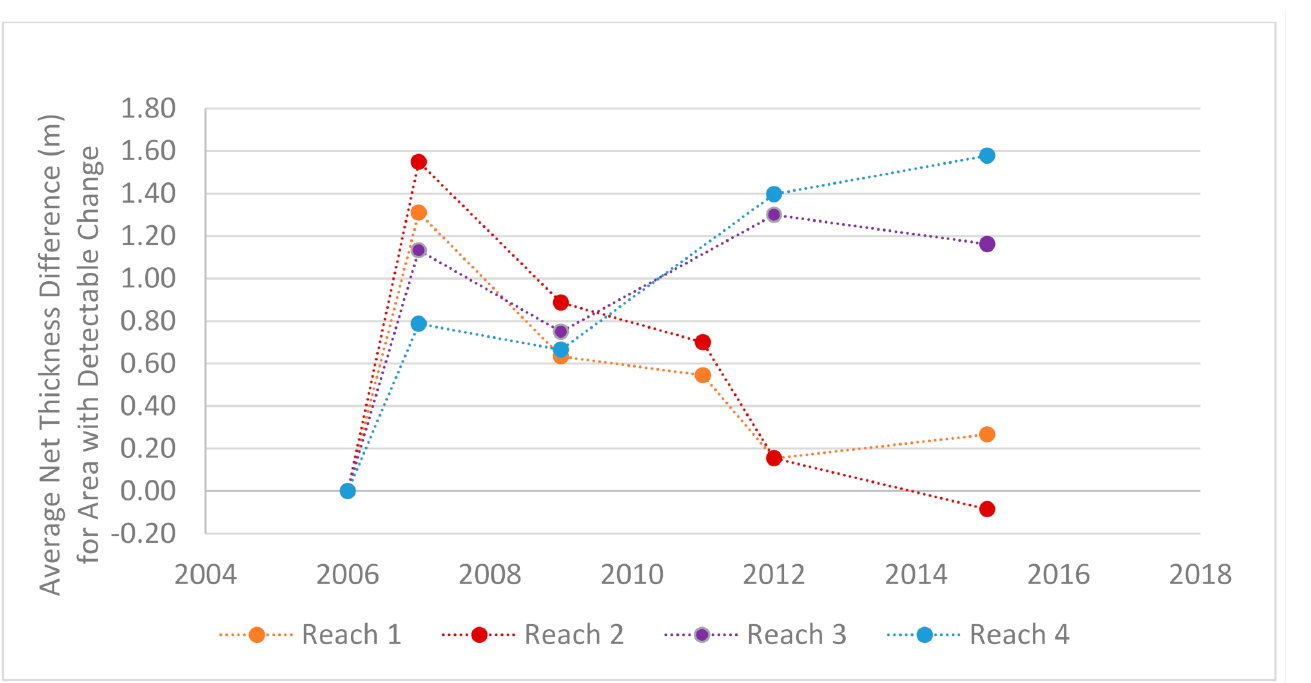
Figure 8. This graph shows the change in average thickness of sediments within the reserved stream corridor reaches. The values reported here show the increase in sediments from the baseline year of 2006, the first year with a high-resolution DEM. The additional sediment in the corridor following the storms of 2006 and 2012 can be seen. The sediment has continued to accumulate within reaches 3 and 4, while reaches 1 and 2 have returned to pre-2006 flood levels. Note: The 2011 survey was only conducted in reaches 1 and 2 and the volume in reaches 3 and 4 are unknown for that time